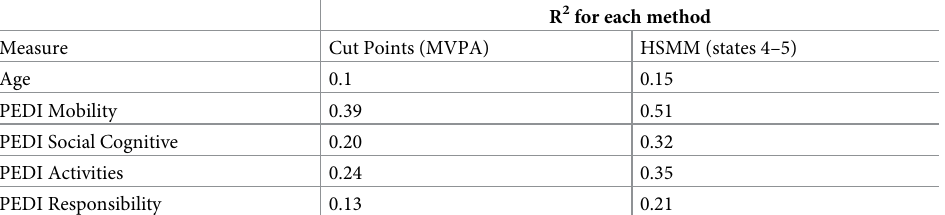
Table 2. Shows the coefficient of determination (R 2 ) calculated on the linear regression of the time spent in HSMM states 4 and 5 or time spent in MVPA with age, and the four domains of the PEDI-CAT measure of